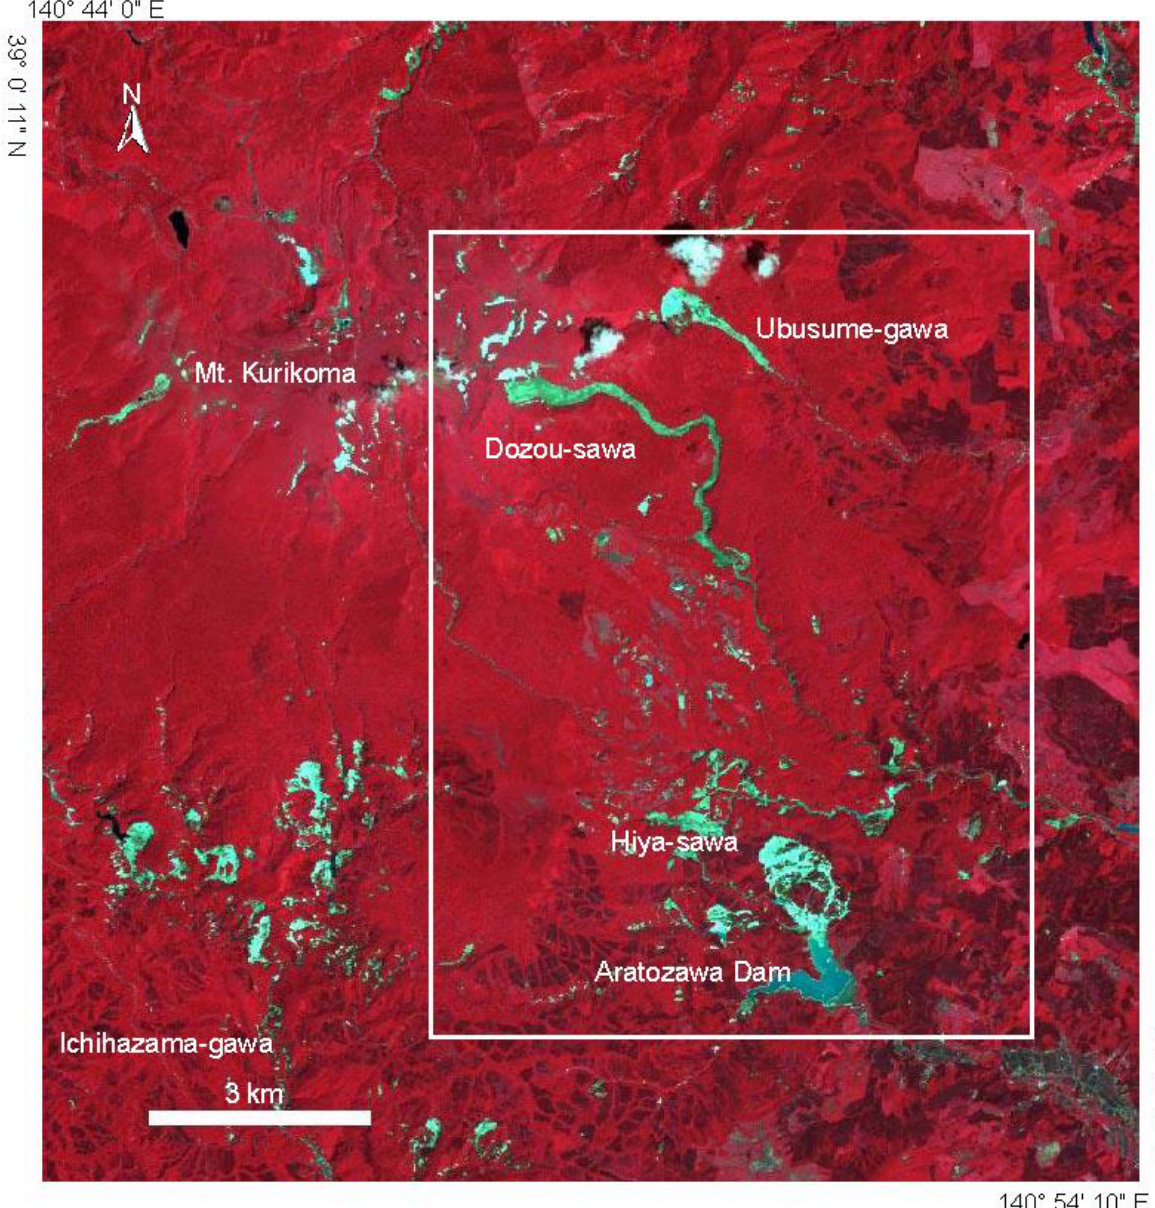
Figure 2. ALOS AVNIR-2 (optical sensor, Advanced Visible and Near-infrared Radiometer type 2) false-color composite (Bands 4, 3, 2 in red, green and blue, respectively) obtained on 2 July 2008 after the 14 June 2008 earthquake. The white rectangle corresponds to the area shown in Figure